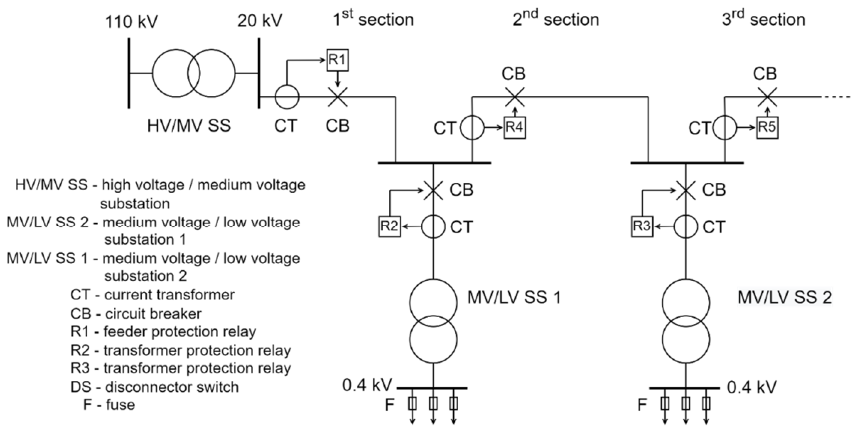
Figure 3. Protection philosophy used in different papers for radial distribution networks.